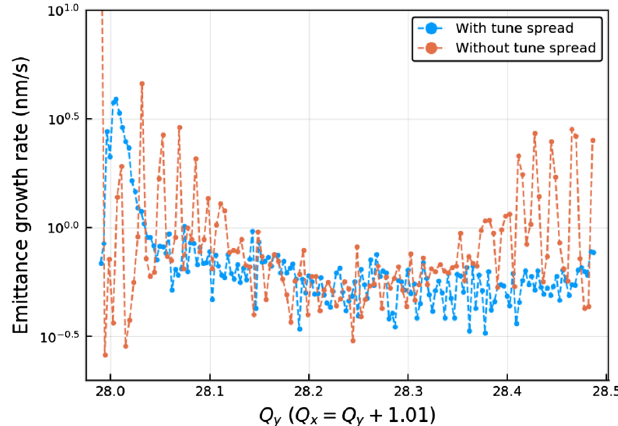
FIG. 11. Dependency of the emittance growth rate on the betatron tune with and without considering the tune spread in the